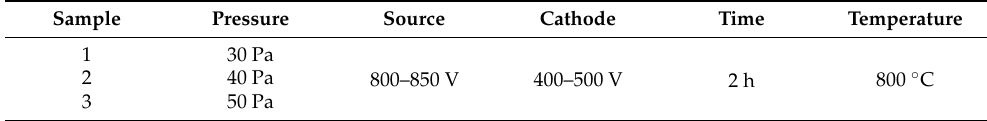
Table 1. Preparation parameters for samples of Nb-Zr alloying